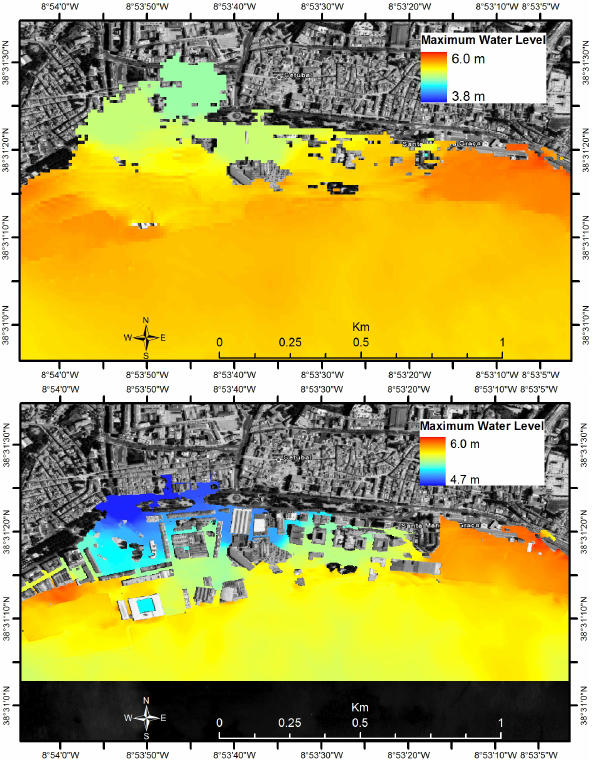
Fig. 5. Set´ubal Inundation areas considering topography only (top) and including buildings (bottom).